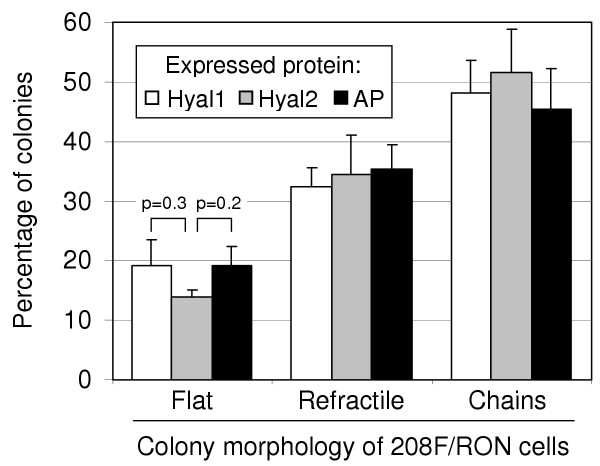
Colony morphology of 208F/RON cells is unaffected by Hyal2 expression. 208F/RON c9 and c10 cells were transduced with retrovirus vectors expressing the indicated proteins, the cells were seeded at low density, and colony morphologies were evaluated 1 week after seeding. Results are means of four experiments (two for each clone) and standard errors are shown.